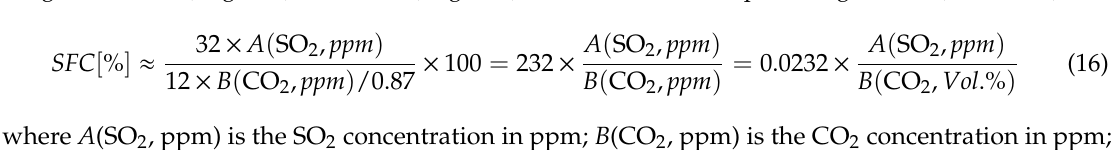
Table 3. Comparison between the average predicted and true sulfur contents.